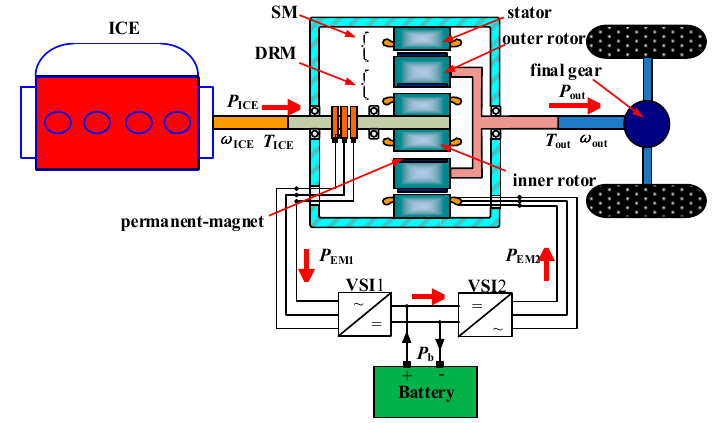
Figure 1. Diagram of hybrid electric vehicles (HEVs) based on compound-structure permanent-magnet motor (CSPM motor).